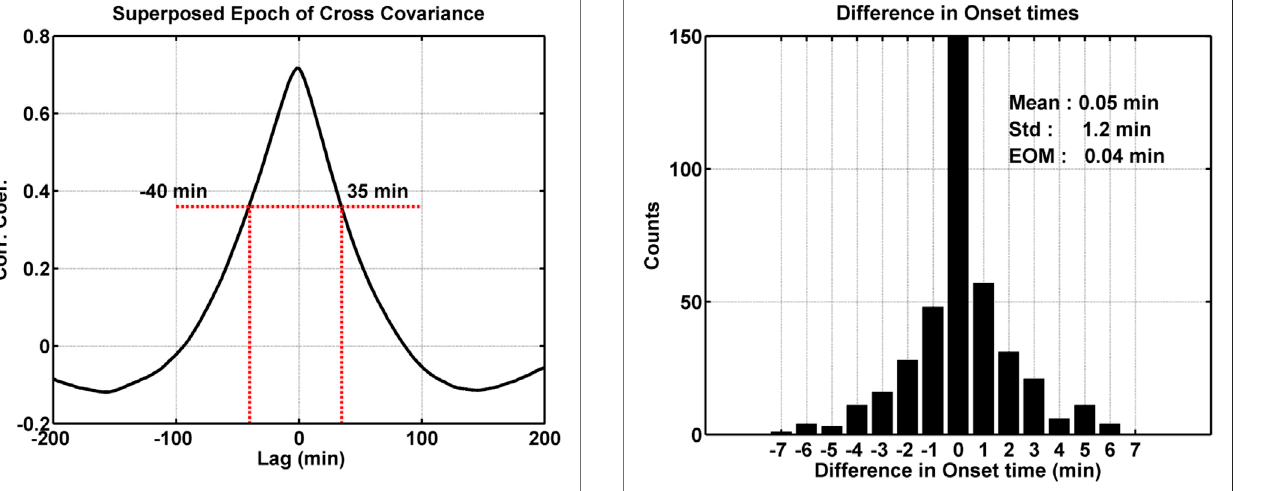
FIGURE 4 | Histogram of differences in the onset time in the H component. The peak of the histogram at zero is off the y-axis scale and is at